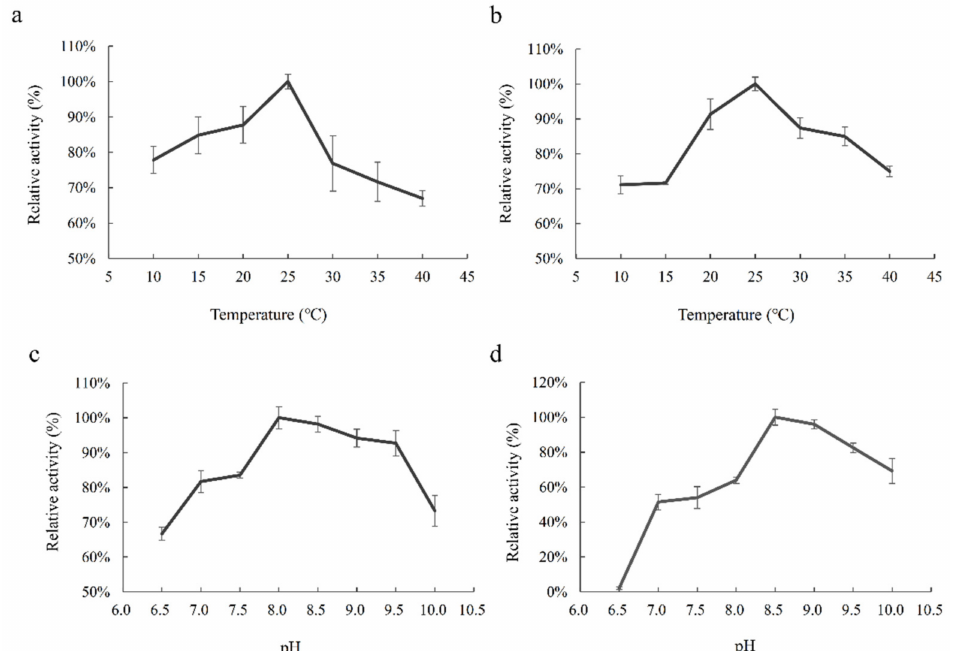
Figure 5. Influence of temperature and pH on the activities of PhGDH1 and PhGDH2. Influence of temperature (10–40 ◦ C) on the activity of PhGDH1 ( a ) and PhGDH2 ( b ). Influence of pH (6.5–10.0) on the activity of PhGDH1 ( c ) and PhGDH2 ( d